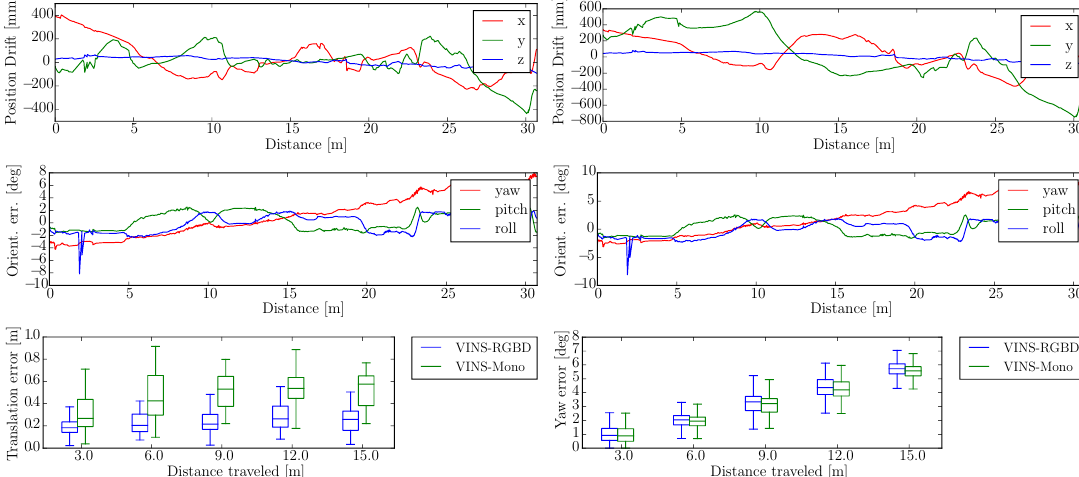
Figure 14. Wheeled Robot Absolute and Relative Error in “Slow” Experiment. The first two rows show the absolute position and orientation error, where the left results are from our VINS-RGBD and right are from VINS-Mono. The last row shows the relative translation and yaw error of our VINS-RGBD and VINS-Mono respectively.